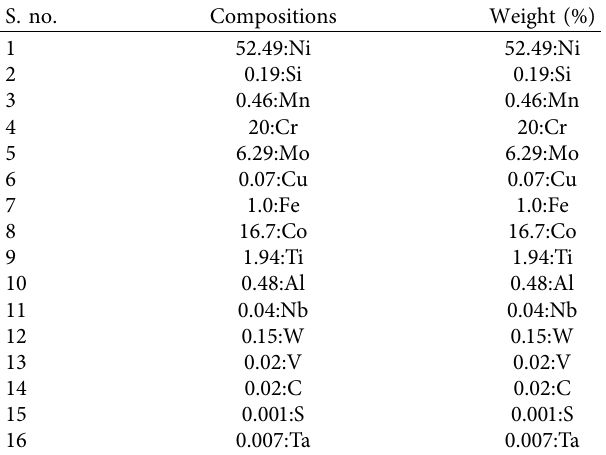
Table 1: Composition of Inconel